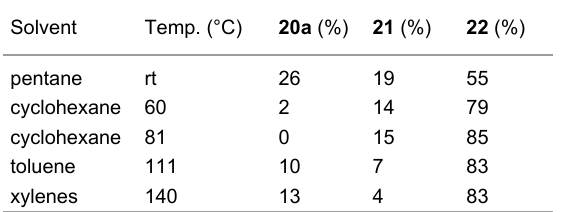
Table 1: Temperature and solvent effects from the addition of DIBAL to 20a . a Solvent